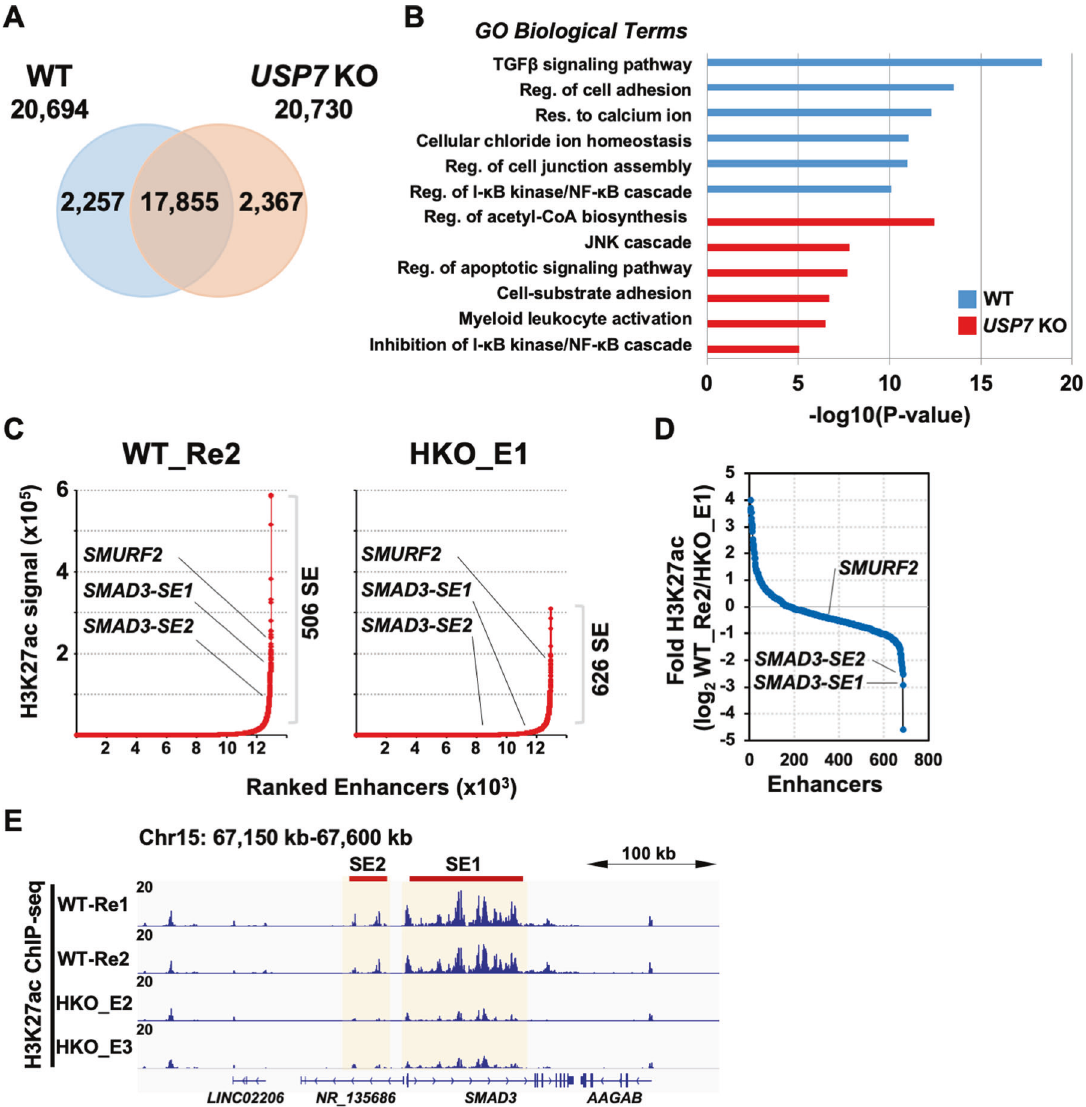
Fig. 2 USP7 KO selectively impairs the super-enhancer of SMAD3 . A Venn diagram summarizing the H3K27ac ChIP-seq peaks identi fi ed in wildtype (WT, overlapped peaks of two biological repeats) and USP7 KO (overlapped peaks of two independent clones HKO_E2 and HKO_E3) H1299 cells. B Gene ontology (GO) biological terms of USP7 WT- and KO-speci fi c H3K27ac ChIP-seq peaks in ( A ) using GREAT analysis. C H3K27ac loading across the enhancers in USP7 WT (left) and KO (right, clone HKO_E2) H1299 cell lines. Super-enhancers (SE) were identi fi ed using the ROSE program with default parameters. Numbers of identi fi ed SE are indicated at right. The SE-associated genes involved in the TGF β -signal pathway were denoted. D The plot showing the fold changes of H3K27ac ChIP-seq signals for all identi fi ed SEs in H1299 cell lines. E IGV gene tracks of H3K27ac ChIP-seq signals in USP7 WT (two biological repeats) and KO (HKO_E2 and HKO_E3) H1299 cell lines at SMAD3 locus. Identi fi ed SE domains (right, SMAD3-SE1; left, SMAD3-SE2) are yellow-colored and indicated at the